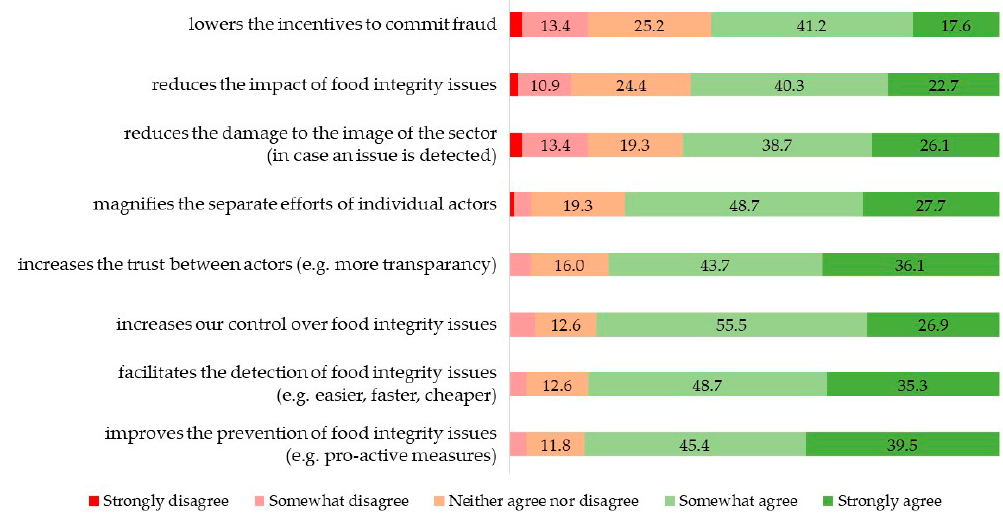
Figure 1. Bubble chart mapping food industry actors’ perceptions of the occurrence of food integrity issues and the likelihood of detecting issues within their companies, identifying three clusters ( n = 133, bubble sizes refer to n , 1 = Cluster 1, 2 = Cluster 2, 3 = Cluster 3).